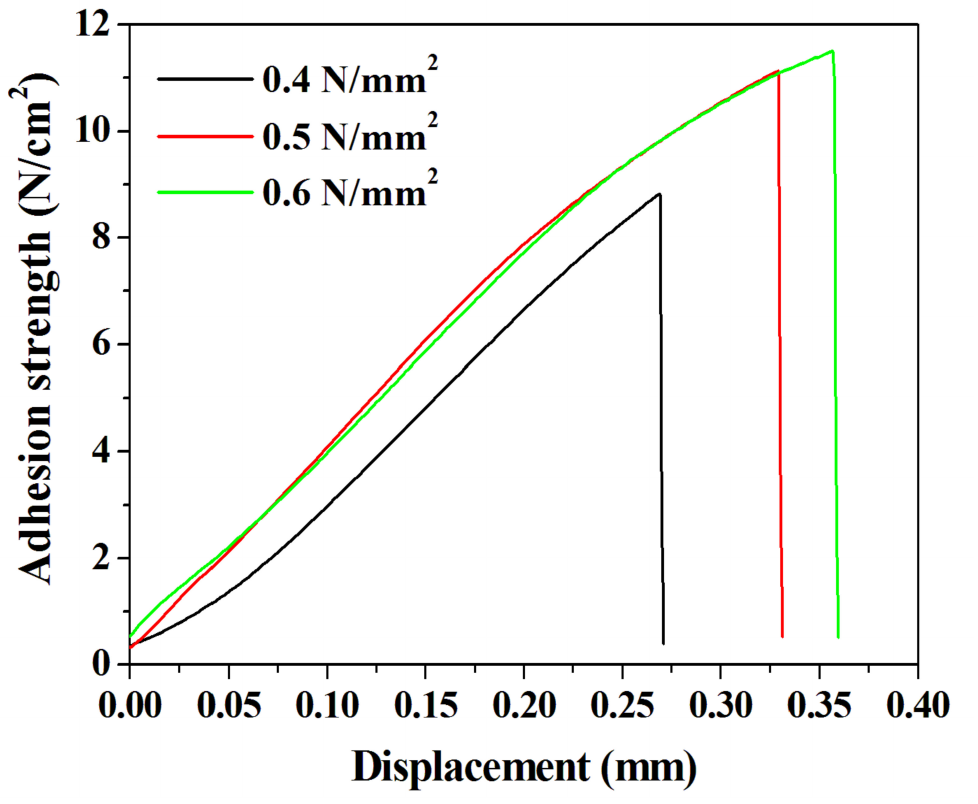
Figure 7. Adhesion test results of the DVS-BCB bonding samples prepared under various compressive pressure